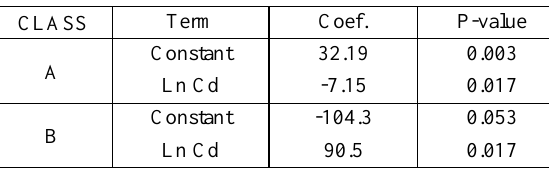
Table 1. P-value and regression coefficients of the adjusted model for classes A and